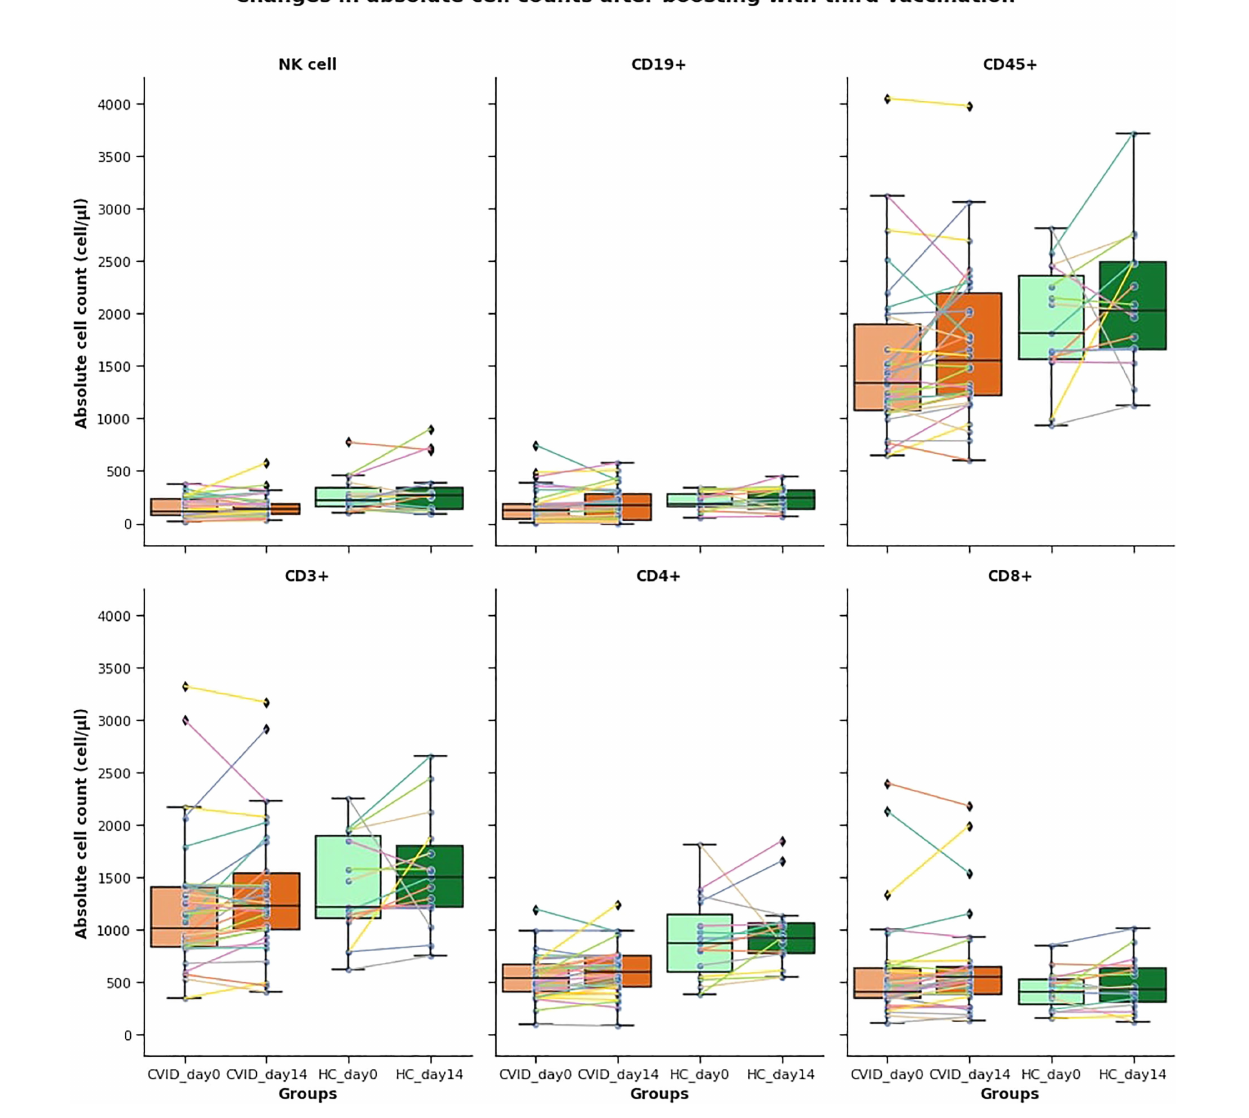
FIGURE 2 | Mean changes in absolute cell counts after boosting at third vaccination. More than 33% of patients and healthy controls have decreased lymphocyte and lymphocyte subpopulation absolute cell counts, therefore we divided the patients and their HC to further subgroups depending on decrease or elevation and illustrated the mean changes of absolute lymphocyte counts in the different subgroups. Mean counts of decreased cell counts were not statistically different in CVID from healthy